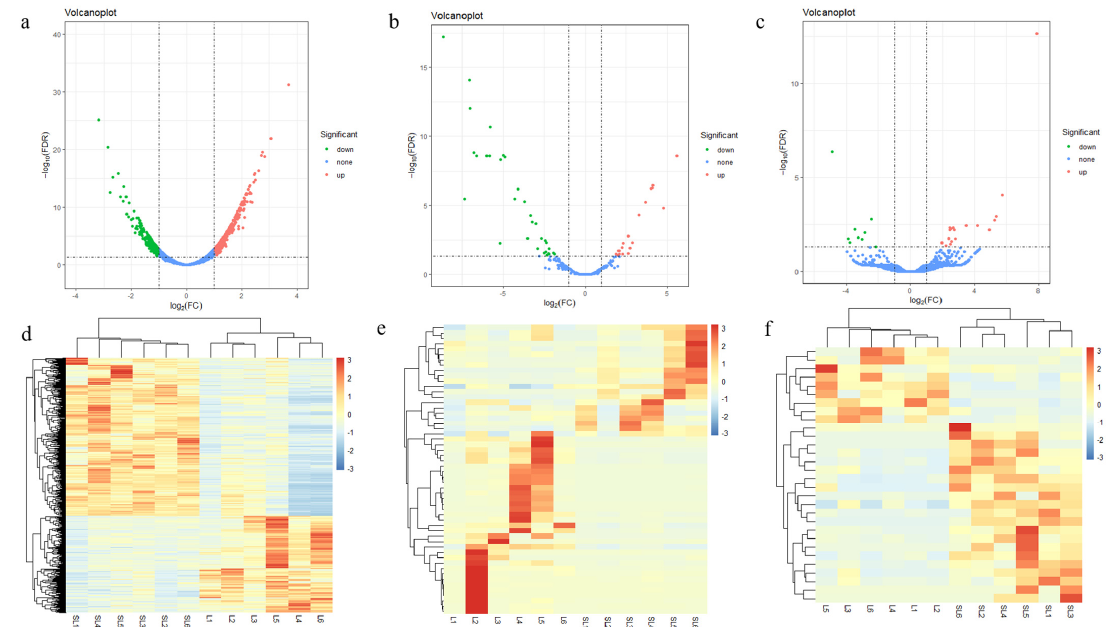
Figure 2. Three differentially expressed RNAs in Songliao black (SL) pigs and Landrace pigs. ( a ) Volcano plot of differentially expressed genes (DEGs); red represents up-regulation in SL pigs, green represents down-regulation in SL pigs, and blue represents no significant difference between SL pigs and Landrace, as below; ( b ) volcano plot of differentially expressed miRNA (DEMs); ( c ) volcano plot of differentially expressed lncRNAs (DELs); ( d ) heatmap of DEGs. The color code represents the expression value, red represents the high expression value, and blue represents the low expression value; SL stands for SL pig and L stands for Landrace; ( e ) heatmap of DEMs; ( f ) heatmap of DELs.